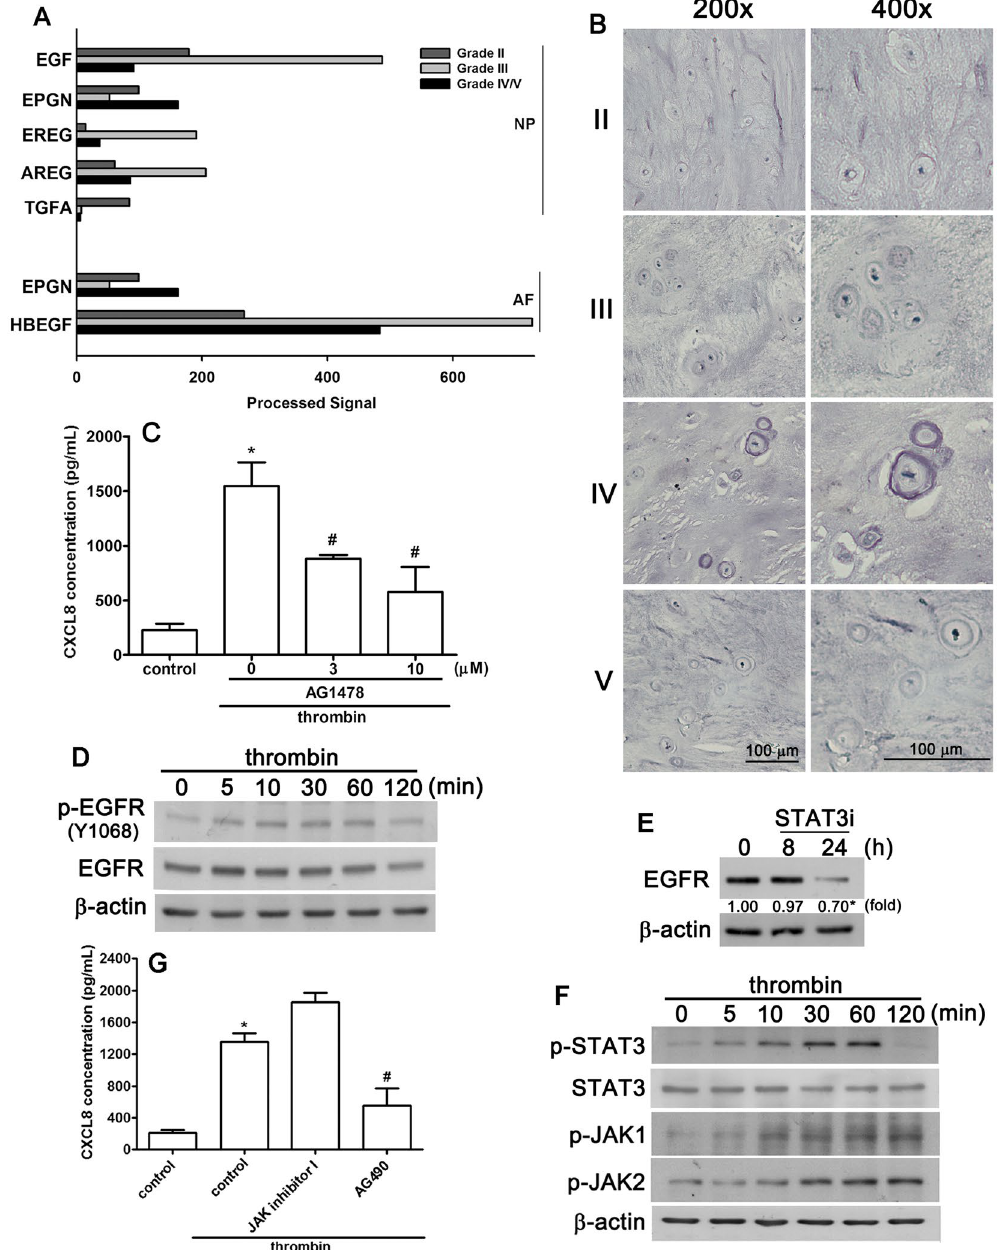
Figure 4. The EGF receptor is involved in thrombin-enhanced CXCL8 expression. ( A ) The mRNA expression of EGF receptor family members in patients with different MRI grades. ( B ) Representative immunohistochemical images of EGFR expression in paraffin-embedded sections at various MRI grades of human spinal disc specimens (three patients in each group). The extent of EGFR staining is slight in tissues with MRI grade III and V patients and strong in the tissue of grade IV patients. ( C ) NP cells were treated with AG1478 (3 or 10 μ M) for 30 min following treatment with thrombin (10 U/mL) for 24 h; expression of CXCL8 was determined by ELISA. Each bar represents the mean ± S.E.M. from at least three independent experiments performed in duplicate. ( D ) NP cells were treated with thrombin for the indicated time periods, cell lysates were separated by SDS-PAGE and immunoblotted with either anti-phosphorylated EGFR (Tyr 1068 ) antibody, anti EGFR antibody or anti β -actin antibody. ( E ) NP cells were treated with the STAT3 inhibitor for 8 or 24 h, and expression of the EGFR was determined by western blot. ( F ) NP cells were treated with thrombin for the indicated time periods and cell lysates were separated by SDS-PAGE and immunoblotted with anti-phosphorylated STAT3, anti-STAT3, anti-phosphorylated-JAK1, or anti-phosphorylated- JAK2 antibodies. Similar results were obtained from four independent experiments. ( G ) NP cells were pre- incubated with the JAK inhibitor 1 or AG490 for 30 min followed by treatment with thrombin (10 U/mL) for 24 h; CXCL8 protein levels were determined by ELISA. Each bar represents the mean ± S.E.M. from three independent experiments performed in duplicate. * p < 0.05 compared with the vehicle control group. # p < 0.05 compared with the thrombin-treated